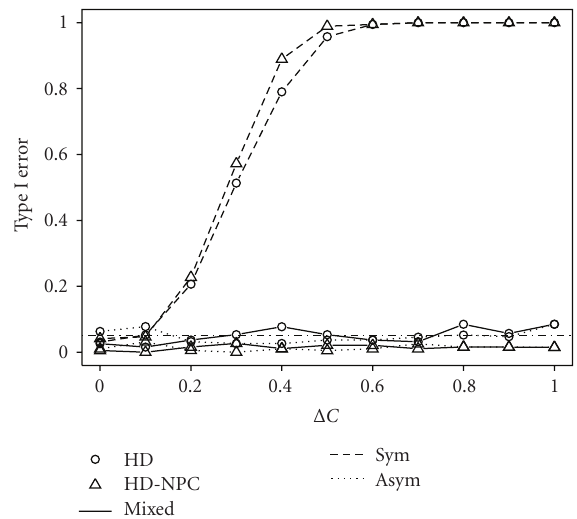
Figure 4: Type I error rate for the HD and HD-NPC approaches for the maternal association test assuming either mating symmetry or asymmetry. Type I error rates are shown as a function of departure from mating symmetry, as measured by Δ C , under the null model where GC 11 = GC 12 = GC 22 = GM 11 = GM 12 = GM 22 = 1 (Table 2, Model 5). Allele prevalence is set at q = 0 . 3. Log-linear, likelihood- based testing (Mother versus Null) was performed assuming either mating asymmetry estimating nine mating-type parameters in the likelihood-ratio tests (Asym), or mating symmetry using only six mating-type parameters in the likelihood-ratio tests (Sym), or with no a priori hypothesis, using a 3 degree-of-freedom likelihood-ratio test to first test the assumption of mating symmetry (Mating Asymmetry (9df) versus Mating Symmetry (6df)) and then using either the mating asymmetry models when asymmetry was detected or the mating symmetry models when it was not (Mixed). Horizontal reference line indicates type I error rate of α = 0.05. HD, hybrid design using parents of controls in a log-linear framework; HD-NPC, log-linear analysis using unrelated controls rather than their